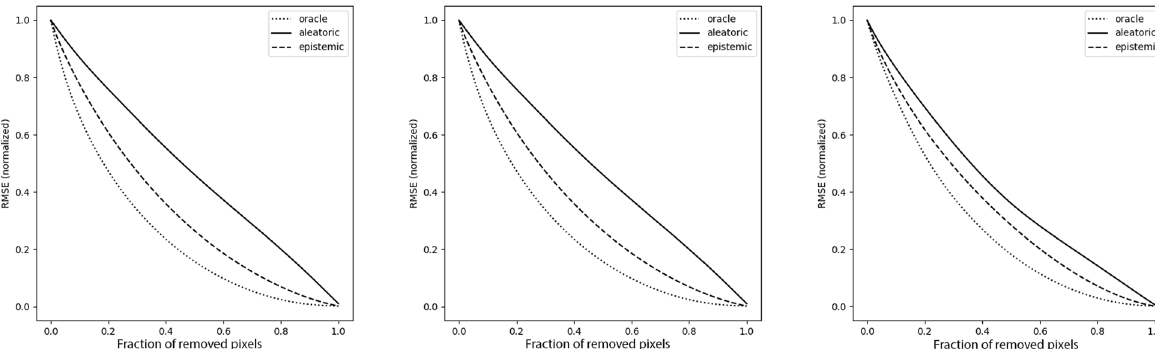
Fig. 16 Sparsity curves for the training dataset. Left: variational; middle: Monte-Carlo dropout; right: ensemble.